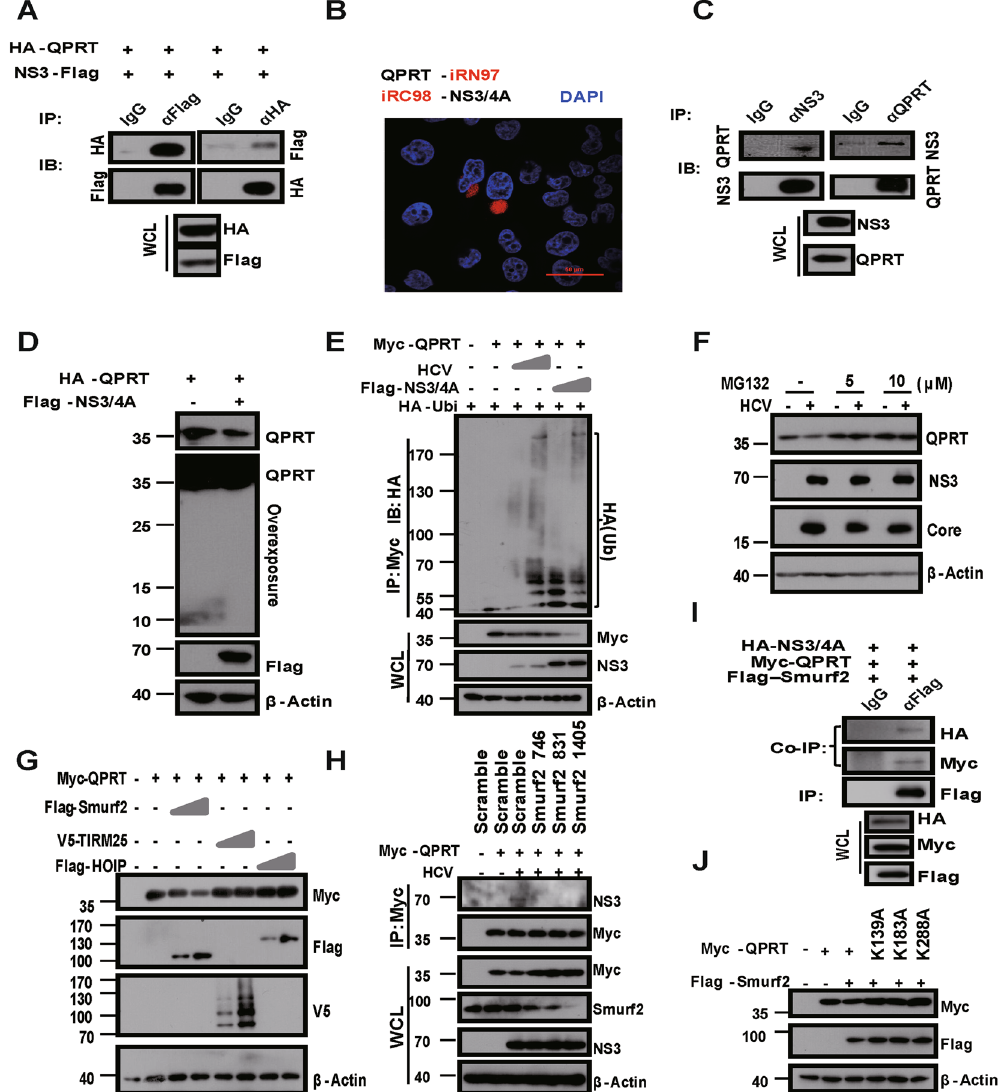
Figure 2. HCV NS3 triggered Smurf2 mediated proteasomal degradation of QPRT. ( A ) Reciprocal co-IP to assess the molecular interaction between the co-expressed NS3-Flag and HA-QPRT in 293T cells using the indicated themes. Mouse IgG was used as a negative control. ( B ) Interaction between co-transfected QPRT- iRN97 and iRC98-NS3/4 A in HeLa cells were assessed for BiFC signals (iRFP channel) by confocal microscopy. The nucleus was counterstained with DAPI (blue channel). Scale bar, 50 μ m. ( C ) Reciprocal co-IP to assess interactions between the nascent NS3 and endogenous QPRT after Huh7.5.1 cells were infected with HCV for 48 h. Mouse IgG was used as a negative control. ( D ) Immunoblotting of HA-QPRT cleavage in the presence of co-expressed Flag-NS3/4A in 293T cells for 24 h. Reduction of QPRT (top panel) and lack of cleaved fragments of QPRT (middle panel, long exposure). ( E ) Ubiquitination of myc-QPRT in the presence of HA-Ubi was assessed by co-IP after Huh7.5.1 cells were transiently co-transfected with Flag-NS3/4A, or infected with HCV, for 24 h. IP efficiency was measured by immunoblotting with Myc antibody, and HCV replication was assessed with NS3 antibody in WCL. ( F ) Degradation of endogenous QPRT was assessed by immunoblotting after Huh7.5.1 cells were infected with HCV for 48 h, in the absence or presence of MG132 treatment for additional 12 h. ( G ) Degradation of Myc-QPRT was monitored by immunoblotting with co-transfected E3 ligases, Flag- Smurf2, V5-TRIM25 or Flag-HOIP, in Huh7.5.1 cells for 48 h. ( H ) co-IP to measure interaction between Myc- QPRT with NS3/4A in the presence of co-transfected mock or different Smurf2 siRNA after HCV infection of Huh7.5.1 cells for 48 h. ( I ) co-IP analysis of the co-expressed Flag-Smurf2 with HA-NS3 and Myc-QPRT in Huh7.5.1 cells. Mouse IgG was used as a negative control. ( J ) Decay of Myc-QPRT and different mutants as indicated was compared by immunoblotting with or without co-transfected Flag-Smurf2 in Huh7.5.1 cells. Full- length gels and blots are included in the Figures S6 and